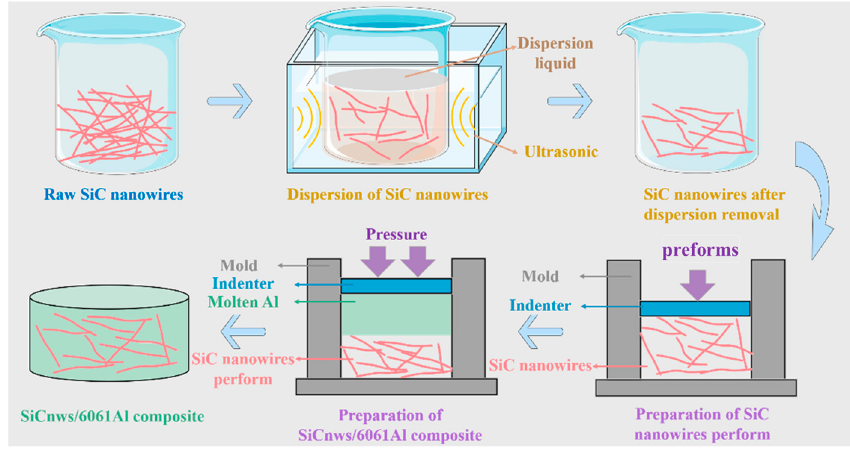
Figure 1. The schematic diagram of preparation of SiCnws/6061Al.